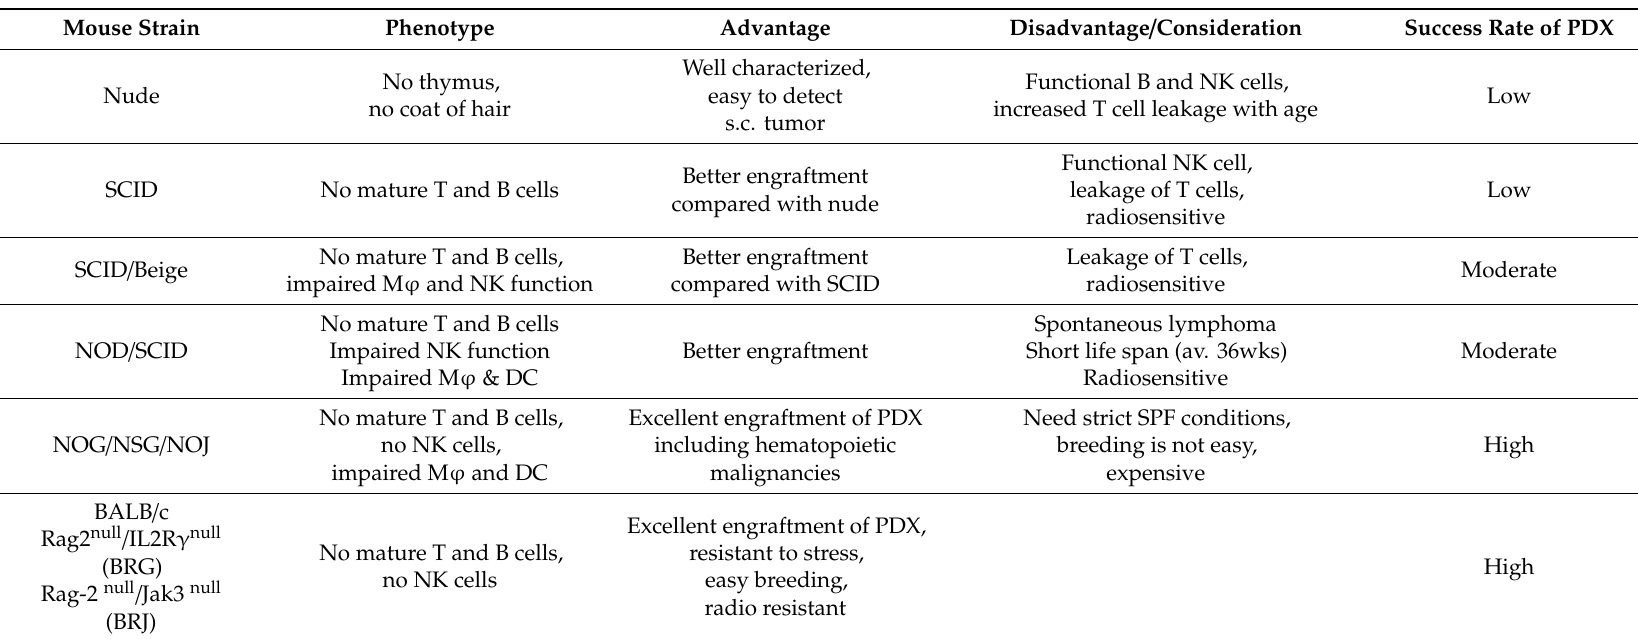
Table 4. Immunocompromised mouse strains for